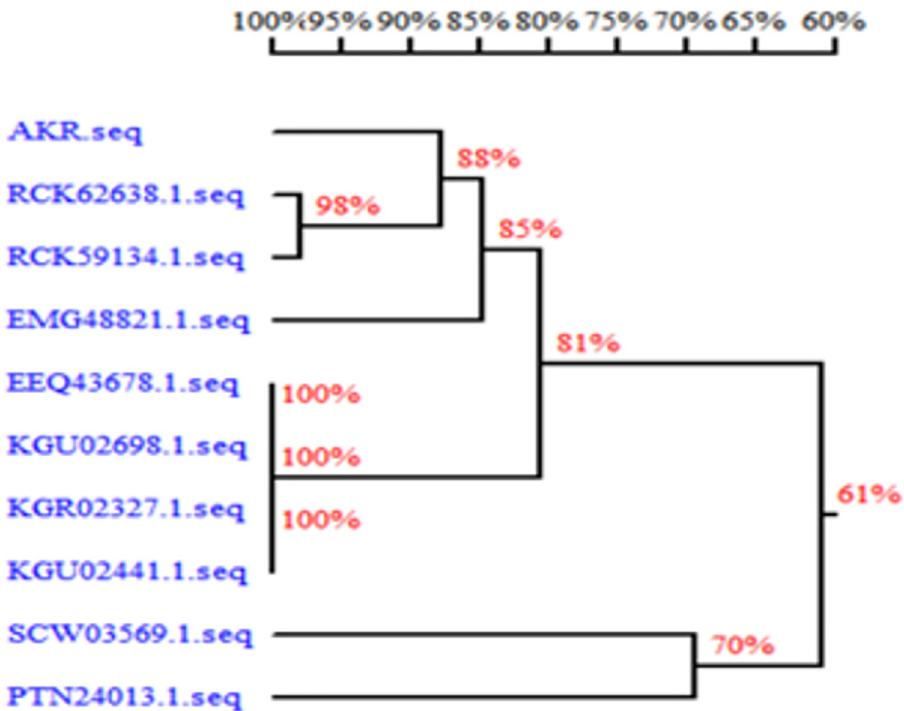
Fig 6. AKR sequence alignment homologous tree.